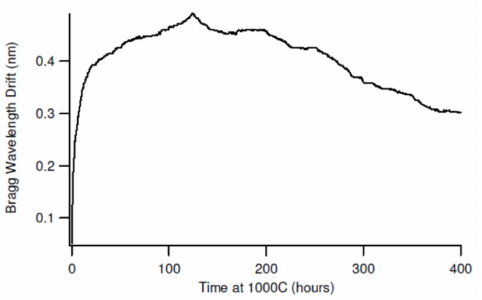
Figure 1. Bragg wavelength drift of a RFBG (reproduced from